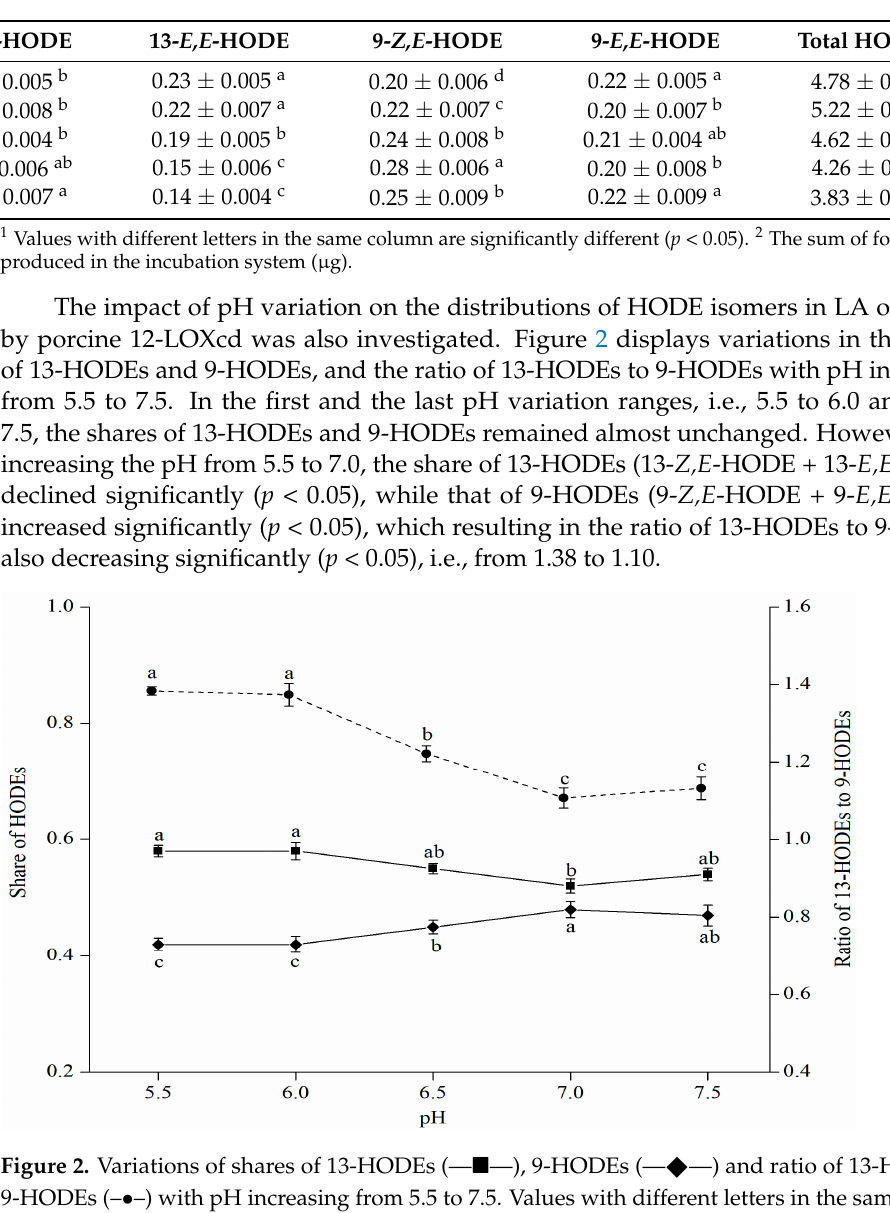
Table 3. Variations of ratio of HODE isomers and yield of HODEs with pH ranging from 5.5 to 7.5 (mean ± SD, n = 3) 1 .